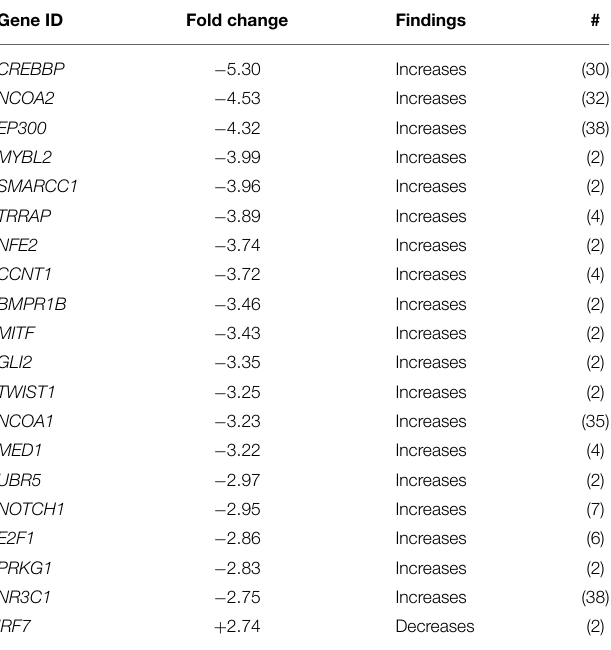
TABLE 2B | Functional annotation under Molecular and Cellular Functions of genes significantly changed between GD90 and GD165.